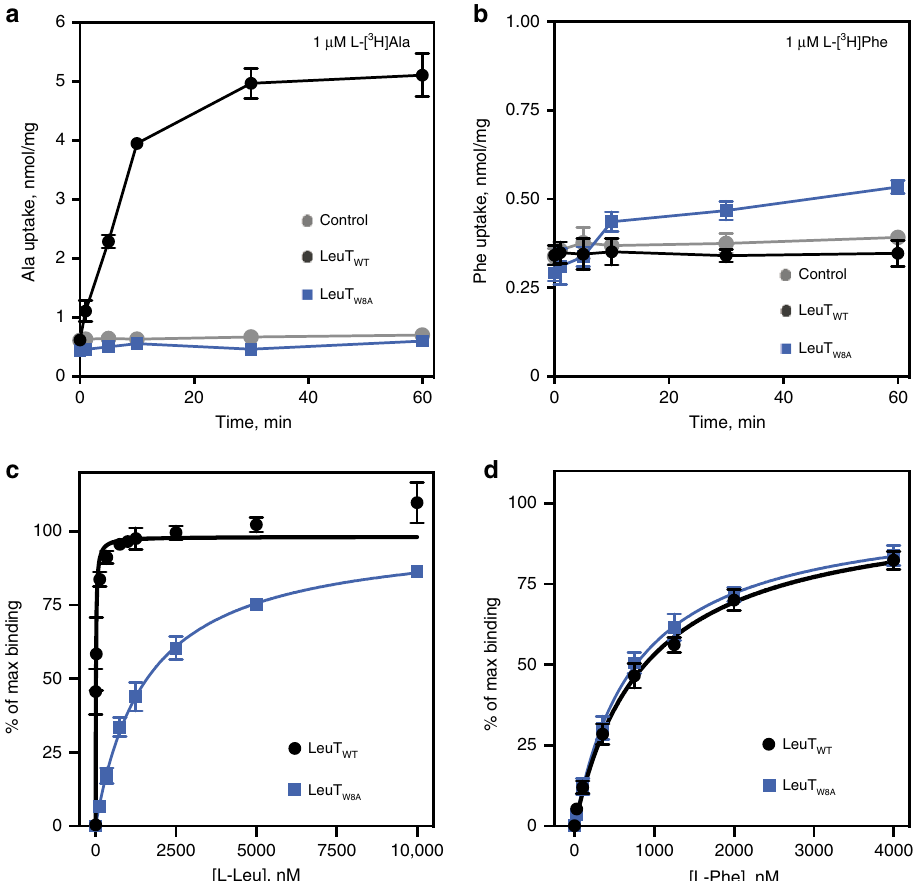
Fig. 3 Comparison of functional properties of LeuT W8A and LeuT WT . a Time course of L -[ 3 H]Ala uptake in proteoliposomes containing LeuT WT (black circles) or LeuT W8A (blue squares) or in control liposomes (gray circles). b Time course of L -[ 3 H]Phe uptake in proteoliposomes containing LeuT WT (black circles) or LeuT W8A (blue squares) or in control liposomes (gray circles). Data in a , b are means ± S.E, n = 2, 3. c , d Saturation binding of L -[ 3 H]Leu ( c ) or L -[ 3 H]Phe ( d ) performed in 200 mM NaCl using a scintillation proximity assay (SPA) on puri fi ed LeuT WT (black circles) or LeuT W8A (blue squares) in detergent solution. Data were fi tted to a one site-speci fi c binding model and are shown as percentage of max binding for each construct. All SPA results are means ± S.E. from n = 3 – 5 independent experiments performed in triplicates. Source data are provided as a Source Data fi